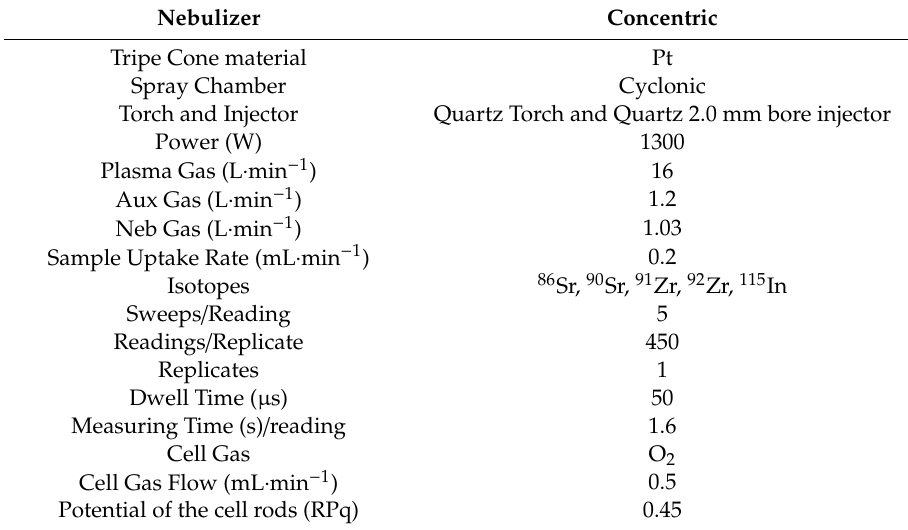
Table 4. NexION ® 300S ICP-MS instrumental